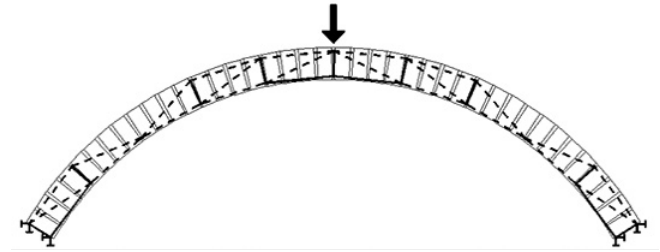
Figure 8. A modified Strut-and-Tie model of the vault from the first